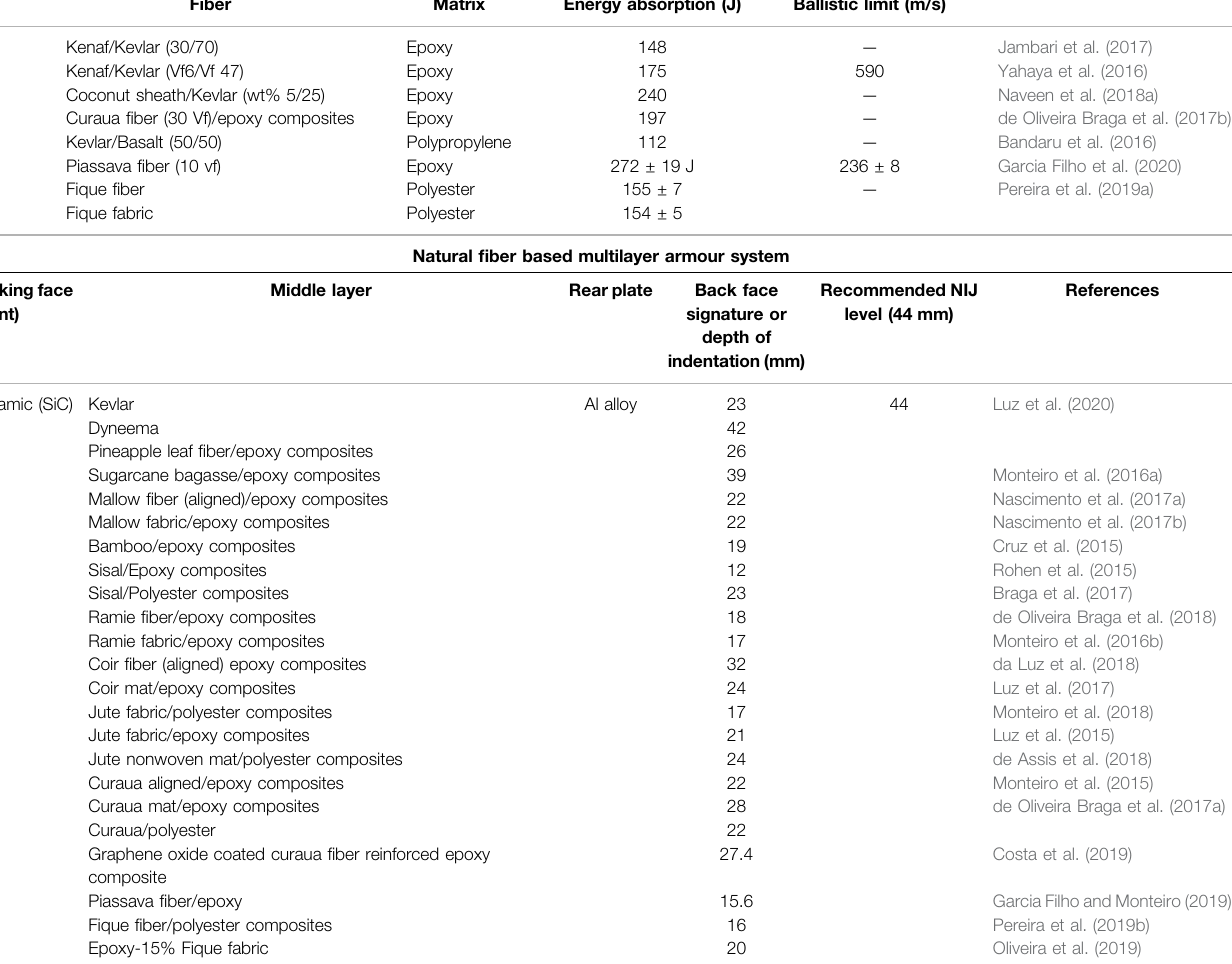
TABLE 1 | Ballistic performance of Natural fi ber based soft and hard armours. Sl.No Natural fi ber based stiff/soft